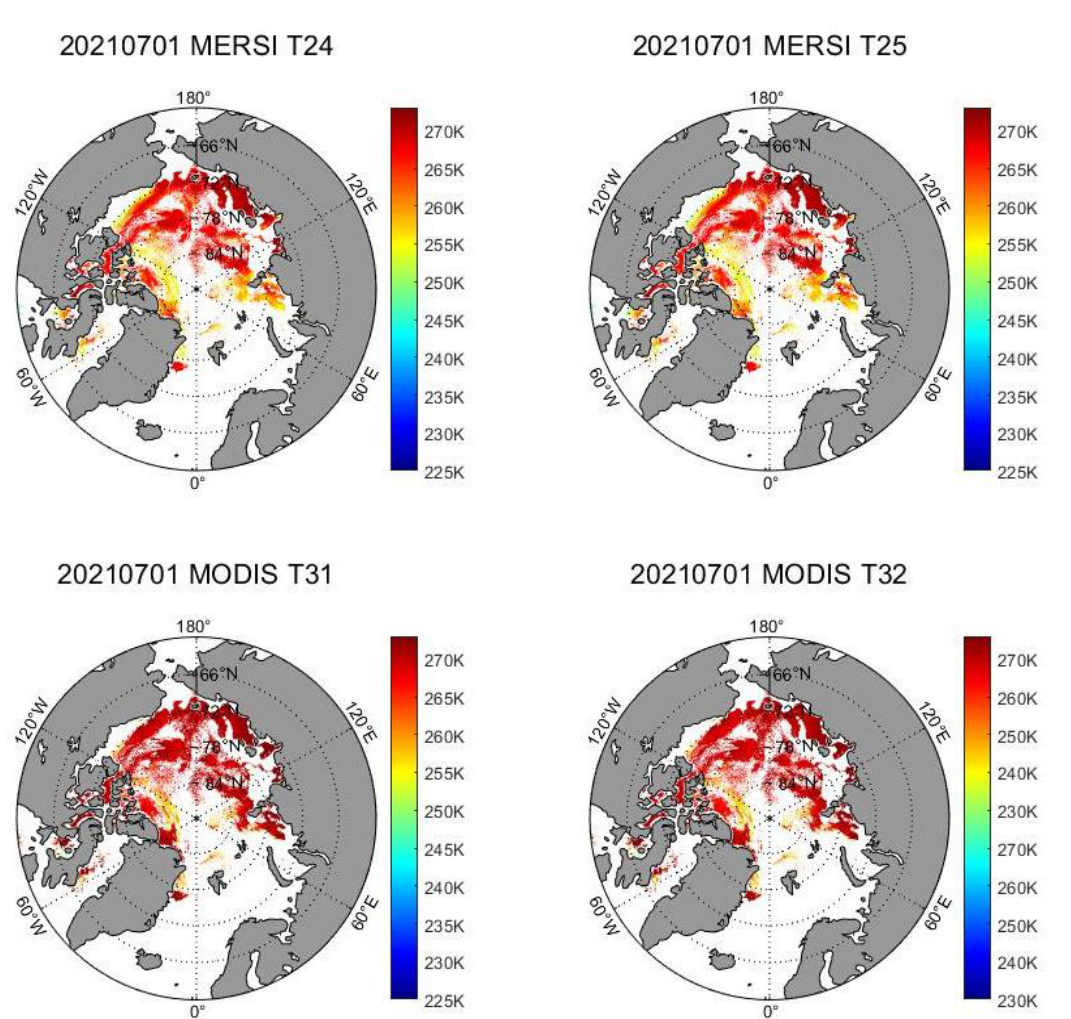
Figure 8. Comparison of distribution maps of MERSI (channels 24 and 25) and MODIS (channels 31 and 32) daily average thermal infrared T b data on 1 July 2021.